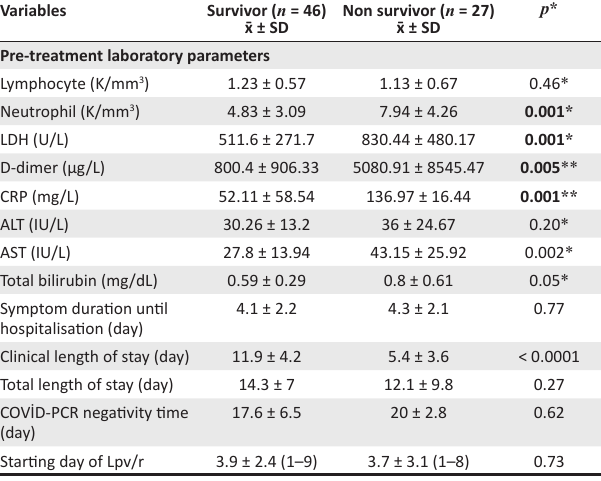
TABLE 4: Comparison of laboratory and clinical parameters before and after lopinavir/ritonavir treatment in surviving patients. Variables ( N = 46)